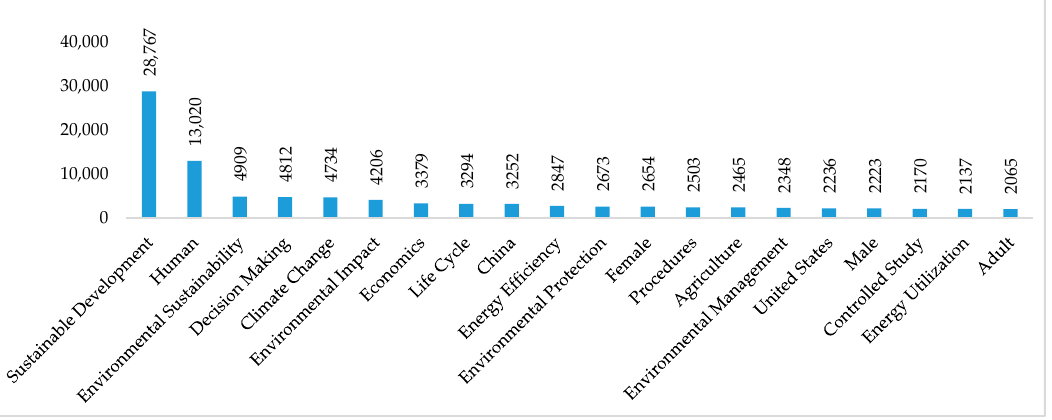
Figure 5. Research topics on sustainability between 2016 and 2020.